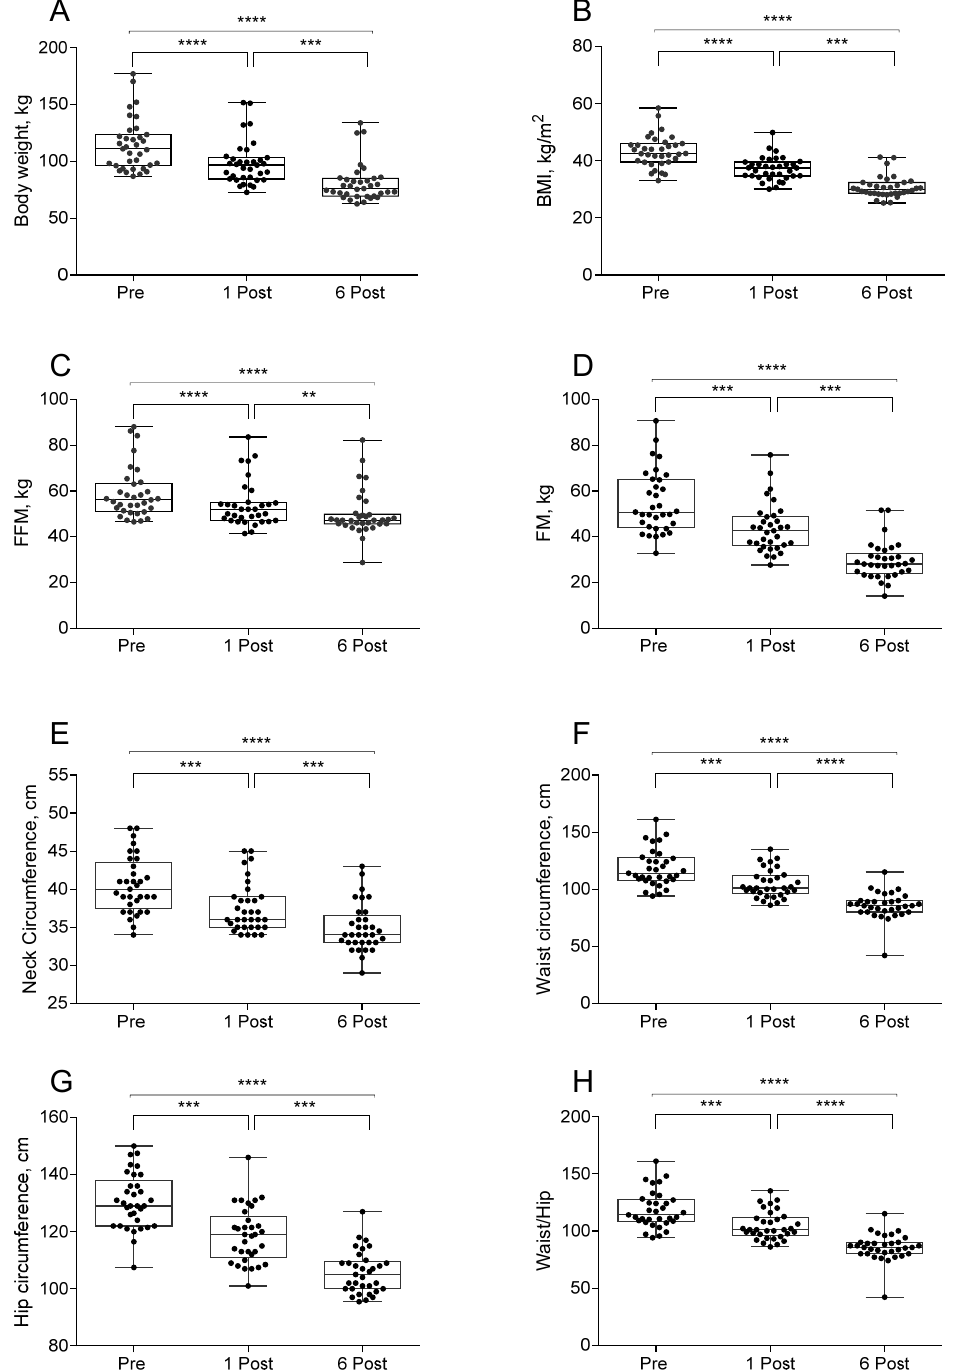
Figure 1. Values of body weight ( A ), body mass index (BMI, ( B )), free fat mass (FFM, ( C )), fat mass (FM, ( D )), neck ( E ), waist ( F ), and hip ( G ) circumferences and waist-to-hip ratio ( H ) in subjects at baseline (Pre), one month (1 Post) and six months (6 Post) after bariatric surgery. Values are presented as boxes (mean value) and whiskers (higher and lower values) (Body weight n = 35; BMI n = 35; FFM kg n = 33; FM kg n = 33; NC n = 33; WC n = 33; HC n = 33). ** p < 0.01; *** p < 0.001; **** p < 0.0001.